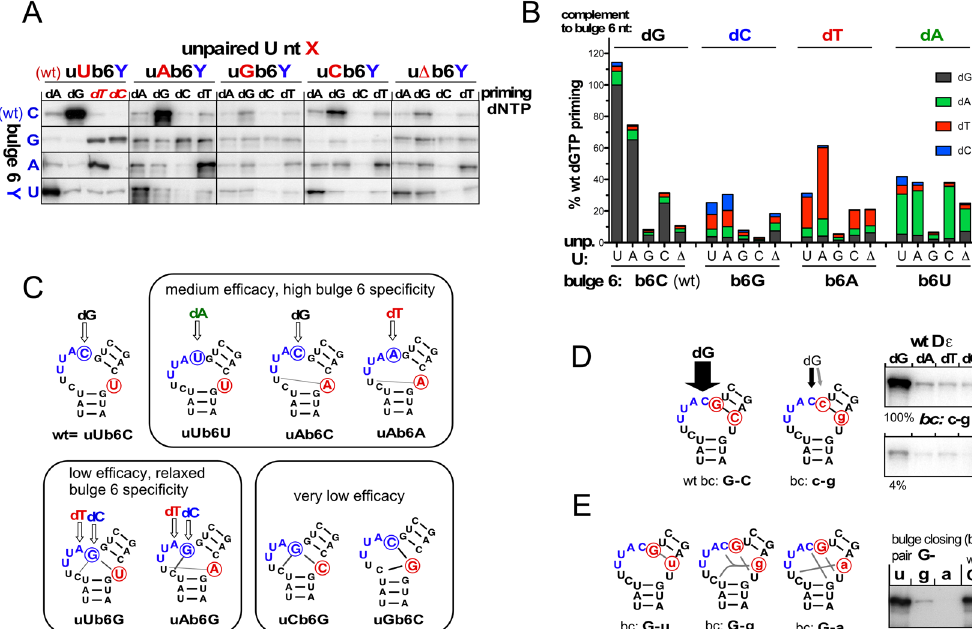
Figure 7. Impact of bulge region architecture on initiation site selection. D ε RNAs in which the unpaired U opposite the bulge (uA, uG, uC, or u Δ where the U was deleted) and the initiation site C at the b6 position (b6G, b6A, b6U) were mutated individually or in combination, were analyzed by miniDP priming assays with either of the four dNTPs. Variants are designated as uXb6Y, with X and Y defining the nt at the unpaired U and the b6 position, respectively. ( A ) Autoradiograms of individual priming assays. Note the preference of all substantially active variants for the nt complementary to the respective b6 position, except those with